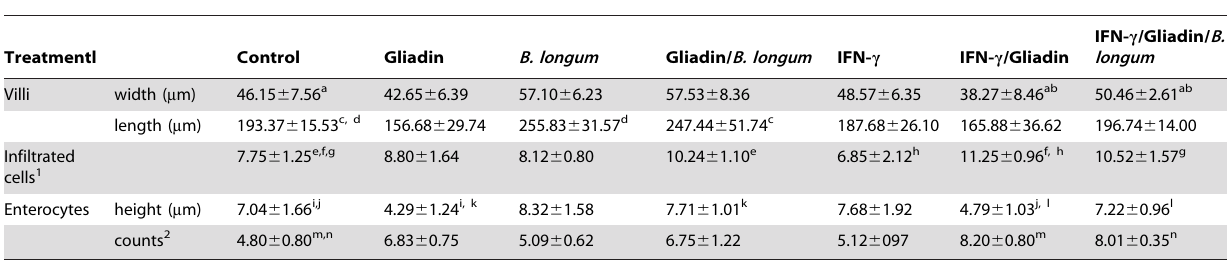
Table 1. Morphometric evaluation of jejunal